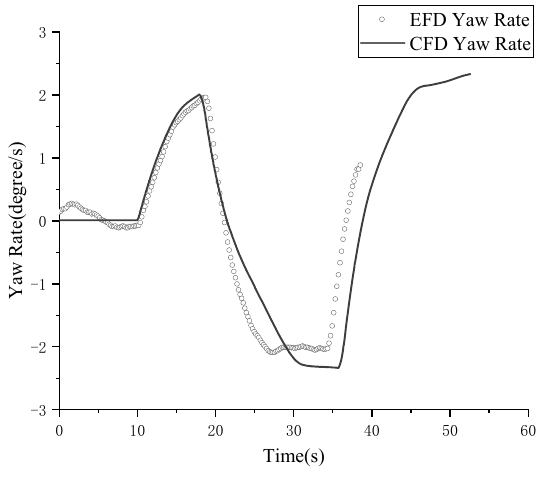
Figure 25. Yaw rate in 10° zigzag maneuver.